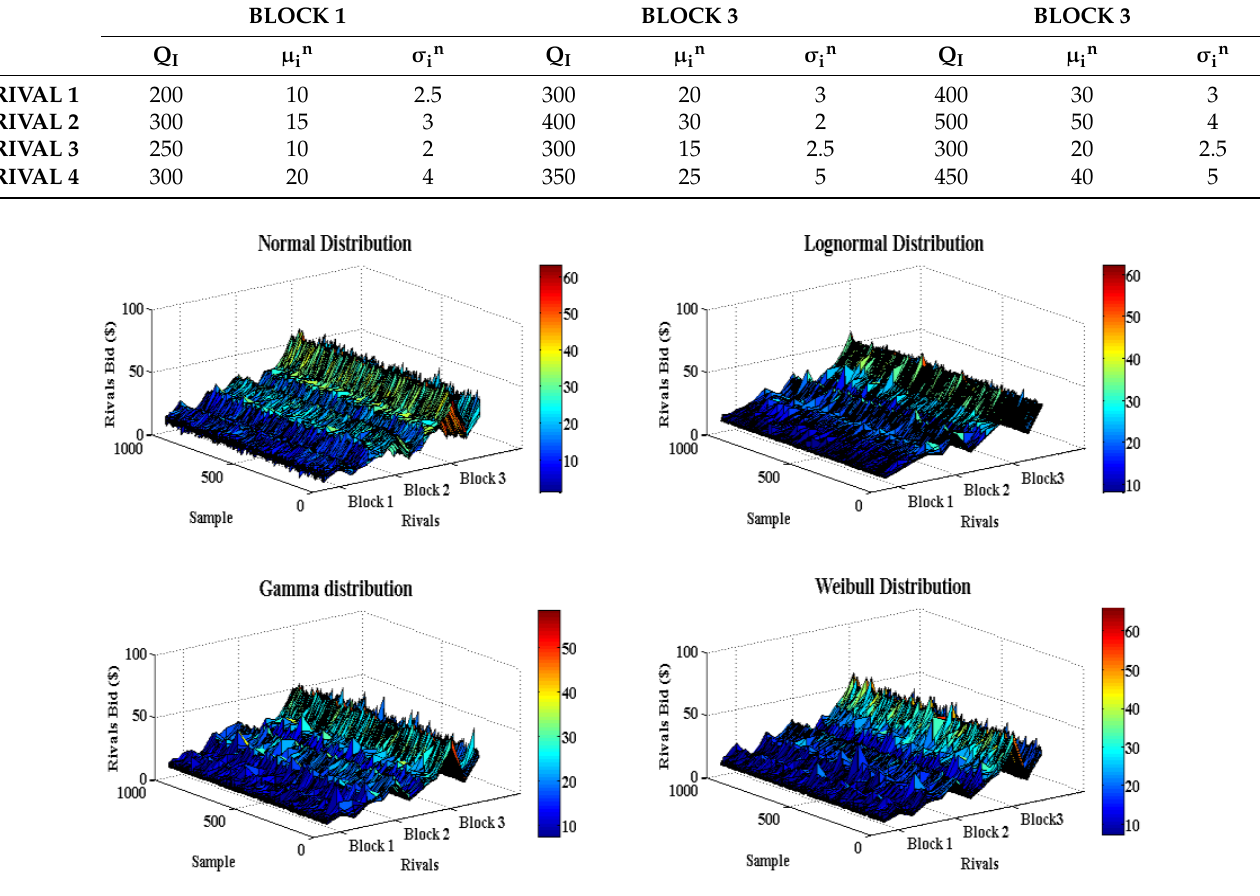
Figure 2. Cost Modal of Different Distributions.